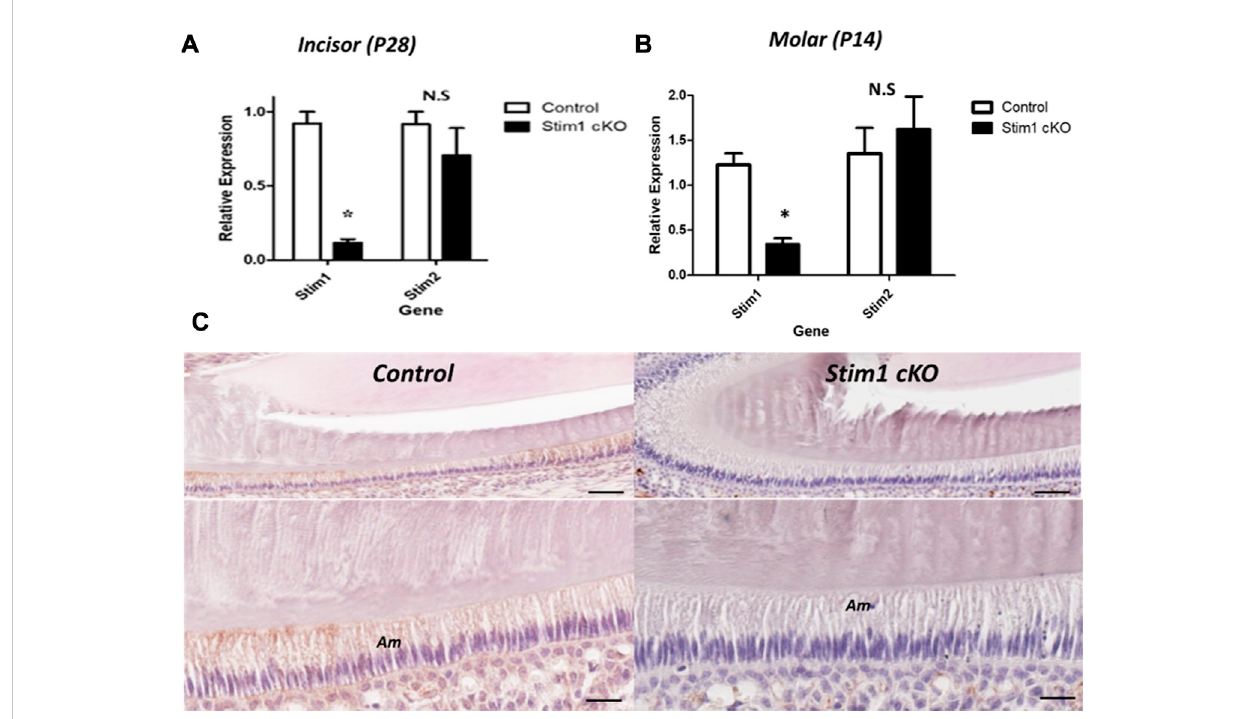
FIGURE 1 Characterization of Stim1 gene deletion. (A,B) RT-qPCR analysis in control and Stim1 cKO ameloblasts collected at postnatal day 28 (P28) from incisors (A) and at postnatal day 14 (P14) from molars (B) showed that the expression levels of Stim1 were signi fi cantly reduced after Stim1 deletion while the levels of its analog Stim2 were not signi fi cantly reduced. (C) IHC of STIM1 antibody con fi rmed deletion of STIM1 protein in the ameloblasts of incisor teeth collected at postnatal day 14; STIM1 was robustly expressed in the ameloblasts (Am) in control mice while it was barely detected in Stim1 conditional knock-out mice. The low mag images of the upper panel are enlarged in the lower panel for each sample. Am, ameloblasts. Scale bars; (C) 80 μ m in low mag panels, 40 μ m in high mag panels. (* p < 0.01), N.S; non-signi fi